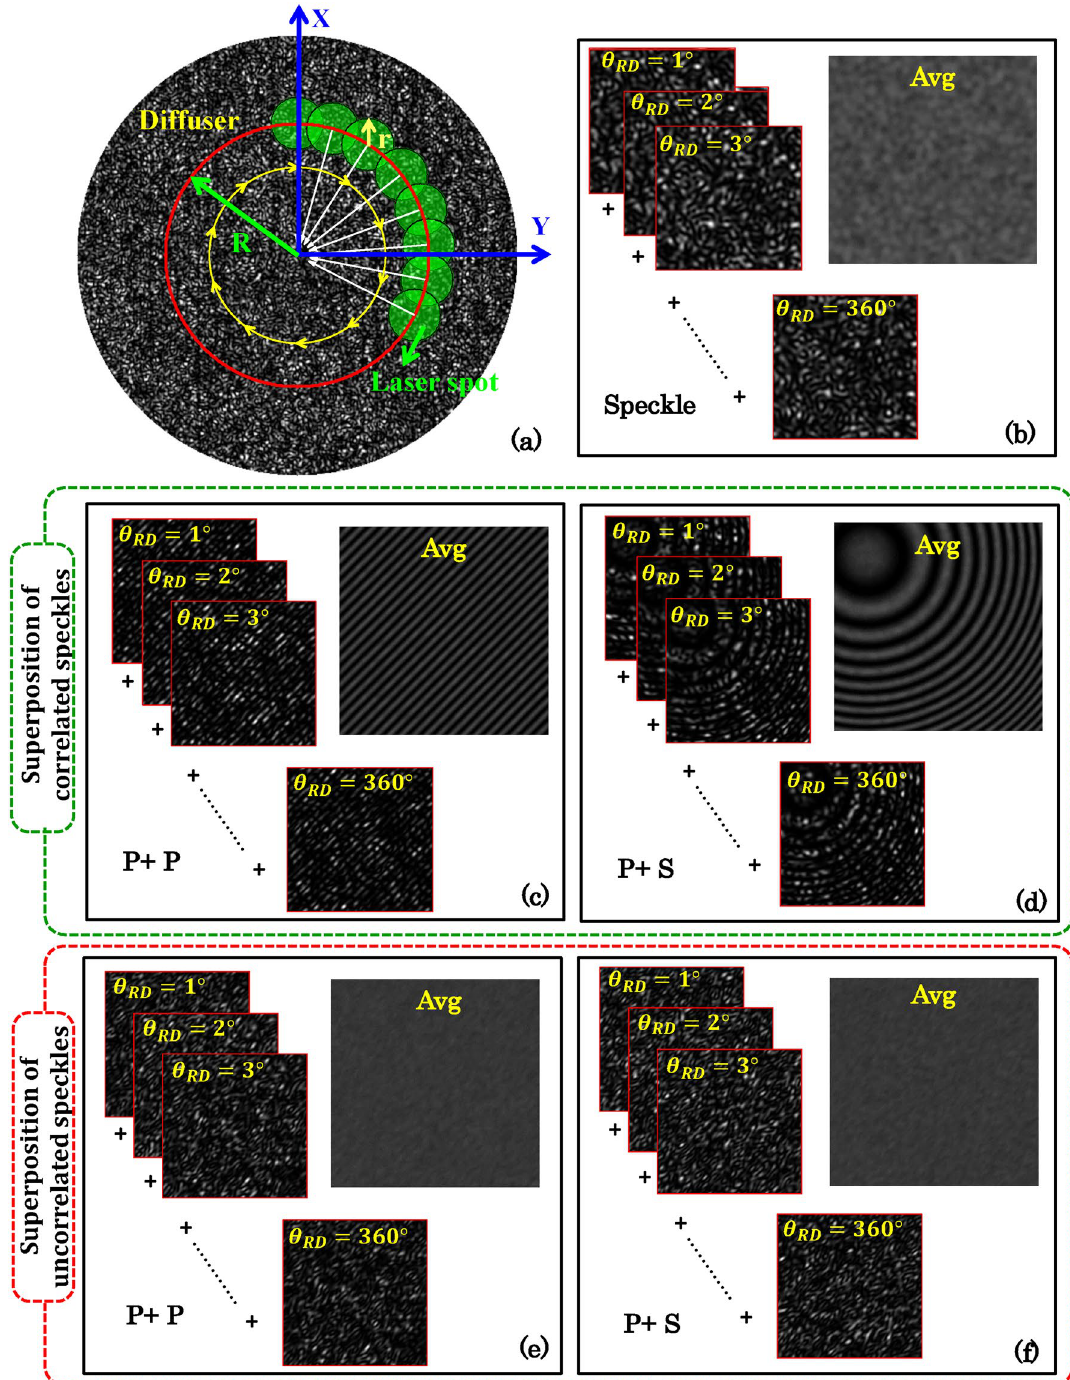
Figure 2. Superposition of correlated and uncorrelated speckle fields. ( a ) Mimicking of the rotating diffuser in the simulation. Green color filled circles represent the laser spot as a function of different rotation angles θ RD . Red color solid circle is the circular path (radius R) of the laser spot (radius r) at the diffuser. ( b ) Represents the series of statistically independent speckle patterns corresponding to different rotation angles θ RD from 0° to 360° in a step of 1° and their average image. ( c , d ) illustrate the specklograms and averaged interferograms generated due to the superposition of correlated object and reference speckle fields for plane and spherical global phase fronts, respectively. ( e , f ) exhibit the resultant intensity patterns generated due to the superposition of uncorrelated object and reference speckle fields for plane and spherical global phase fronts, respectively. P and S are defined as; P: Plane phase fronts and S: Spherical phase